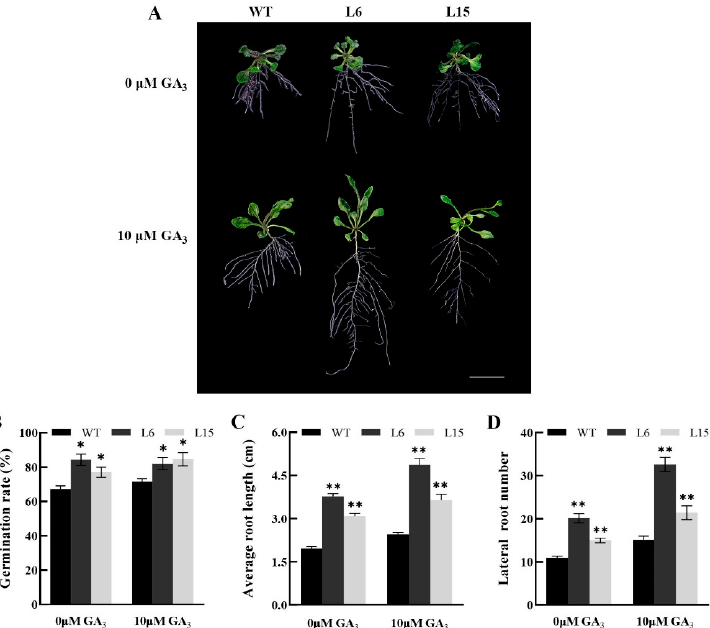
Figure 9. Effects comparison of GA 3 treatment on CpSRG1 transgenic and wild-type Arabidopsis . ( A ) The phenotype of fifteen-day-old plants under GA 3 treatment. Bar denotes 1 cm. ( B ) Germination rate. ( C ) Average root length. ( D ) lateral root number. WT (wild-type plants, Col-0); L6 & L5, transgenic plants overexpressed CpSRG1 . Data represent mean of three biological repeats ± SEM. Error bars indicate the standard error of mean. Asterisks denote statistically significant differences compared with control, * p < 0.05, ** p < 0.01.